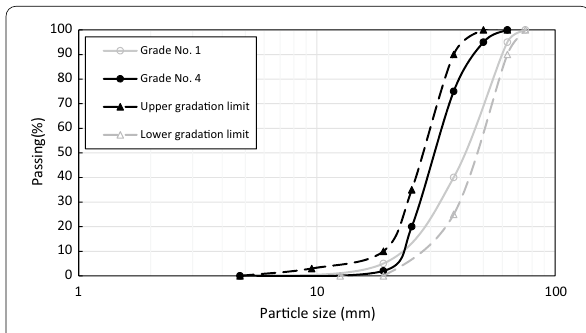
Fig. 3 Particle size distribution of the ballast.